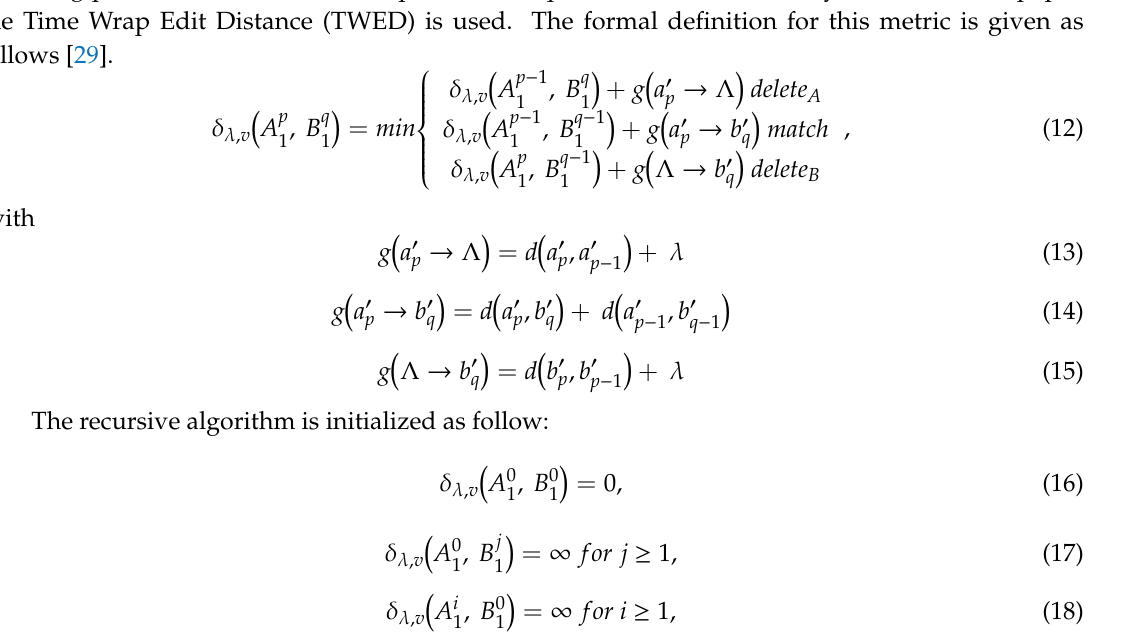
Figure 6. Proposed implementation of Dirichlet Process Mixture Model (DPMM).